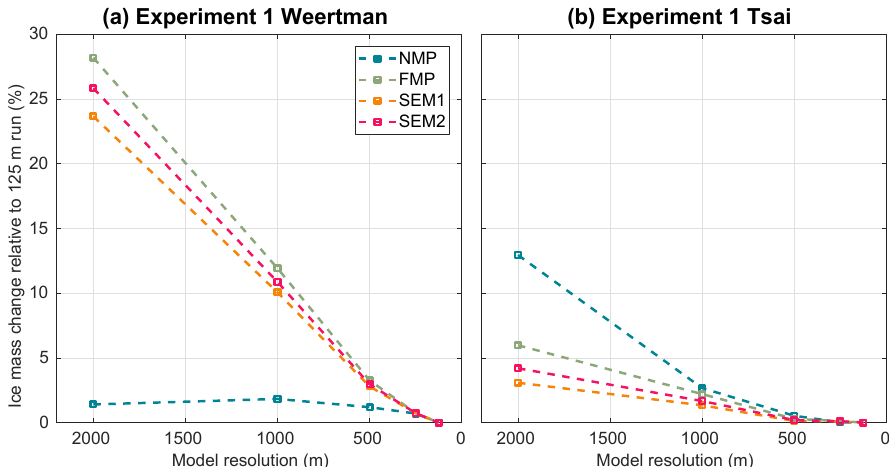
Figure 7. Convergence of ice volume above floatation at the end of experiment 1 as a function of mesh resolution. Absolute error relative to the corresponding 125 mesh resolution results (same friction law and melt parameterization scheme) for the Weertman (a) and Tsai (b) friction laws for the NMP (blue), FMP (green), SEM1 (orange), and SEM2 (red).